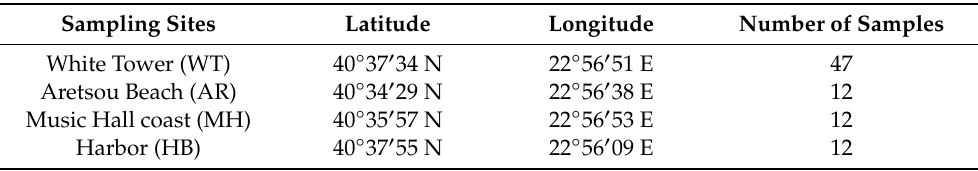
Table 1. Sampling sites and total number of samples